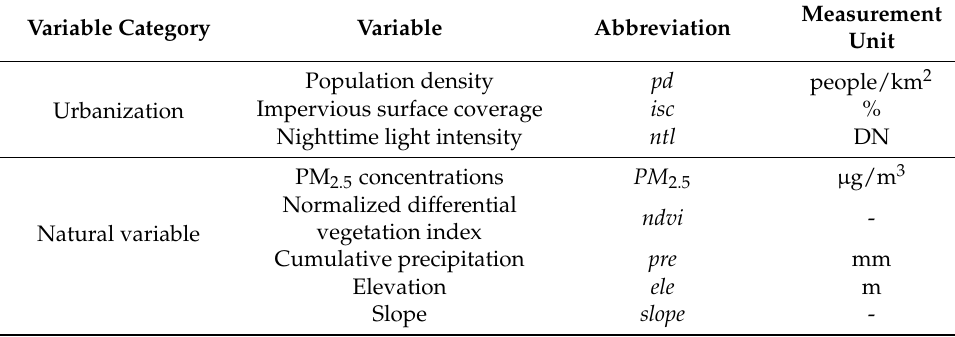
Table 1. Variables setting and